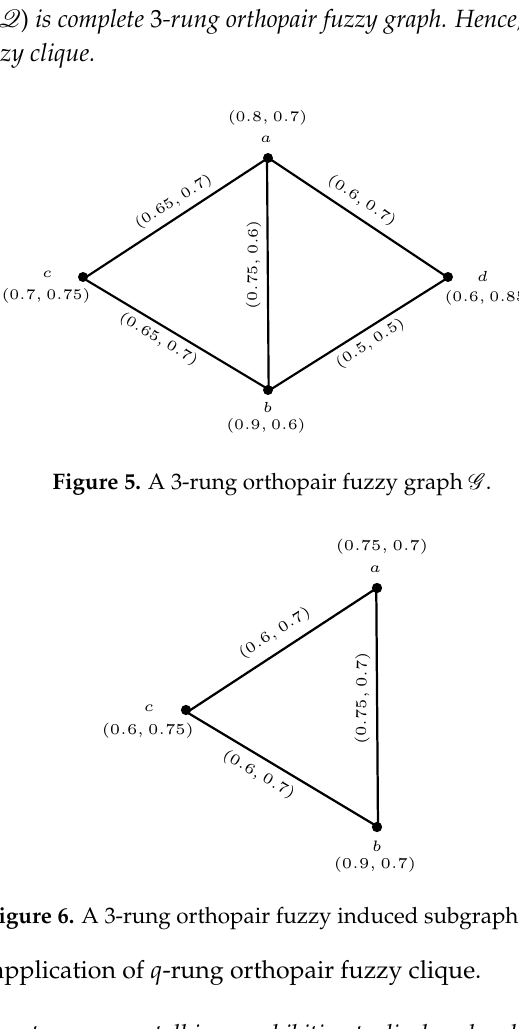
Figure 3.4: A 3-rung orthopair fuzzy induced subgraph H